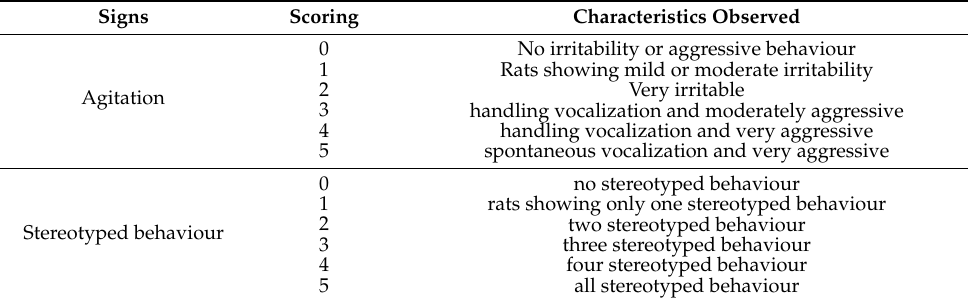
Table 1. Scoring of agitation and stereotyped